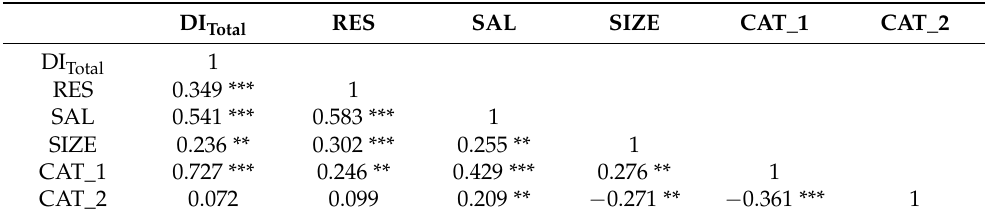
Table 3. Correlation matrix for